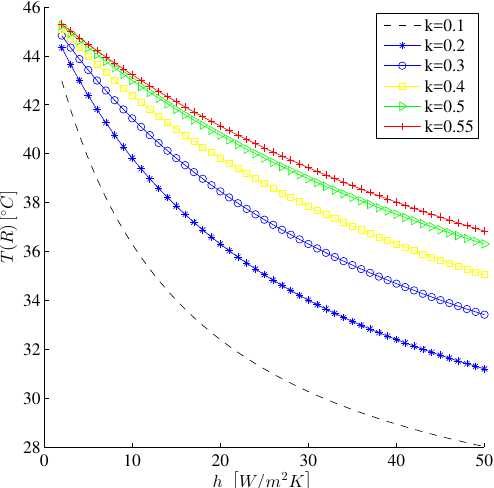
Figure 1. Steady state surface temperature on the cylinder’s convex side against heat transfer coefficient for different values of thermal